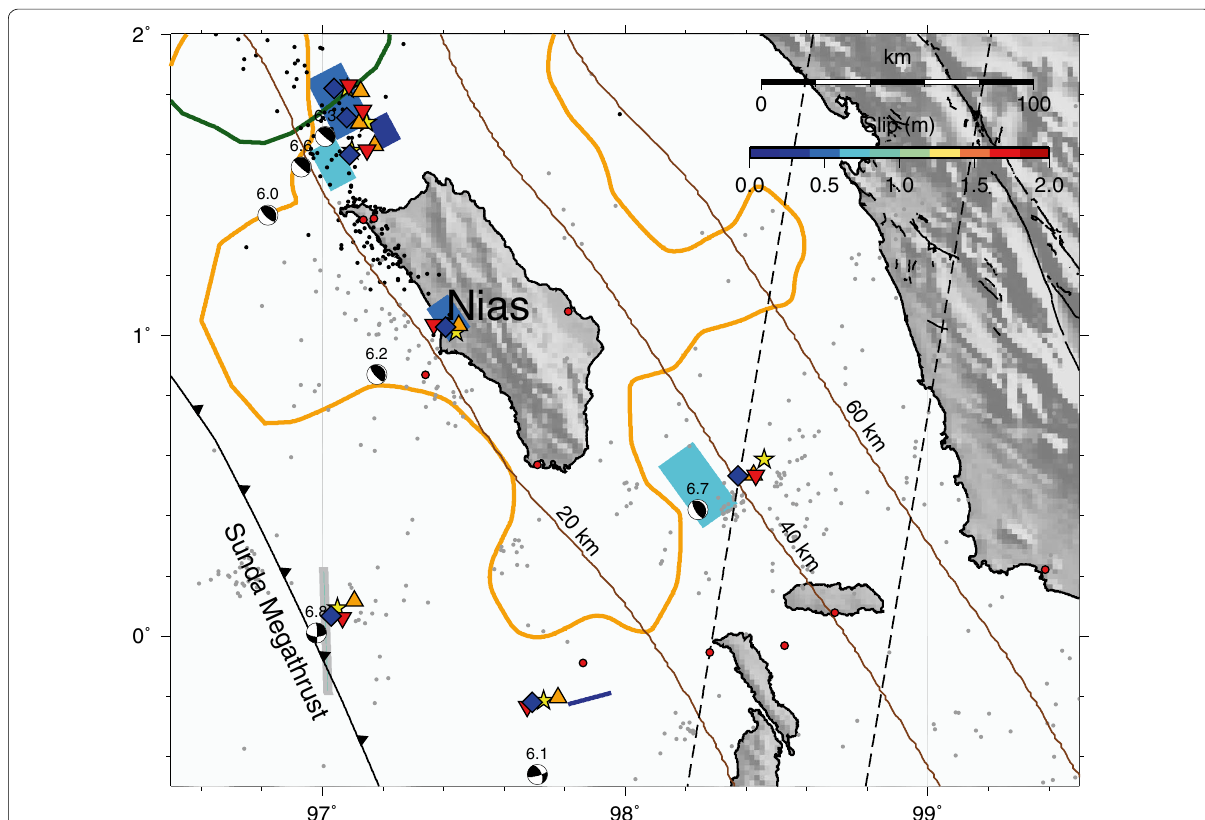
Fig. 7 Map of seven modeled earthquakes in the Nias section. Black dots indicate seismicity between October 2005 and March 2006 located by Tilmann et al. (2010). Gray dots indicate seismicity between April 2008 and February 2009 located by Lange et al. (2010). See the captions of Figs.